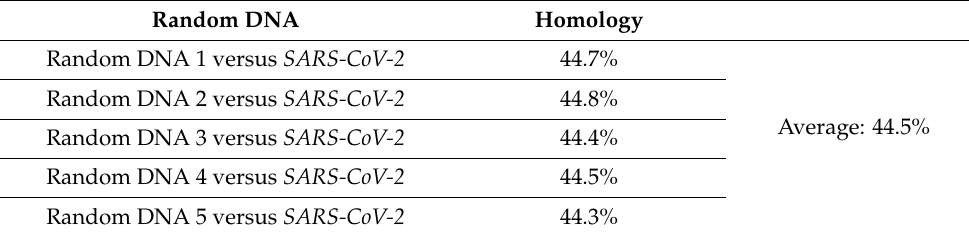
Table 2. Randomized computer-generated nucleotide sequences of 30 kbp and their sites of sequence coincidences with the sequence of the SARS-CoV-2